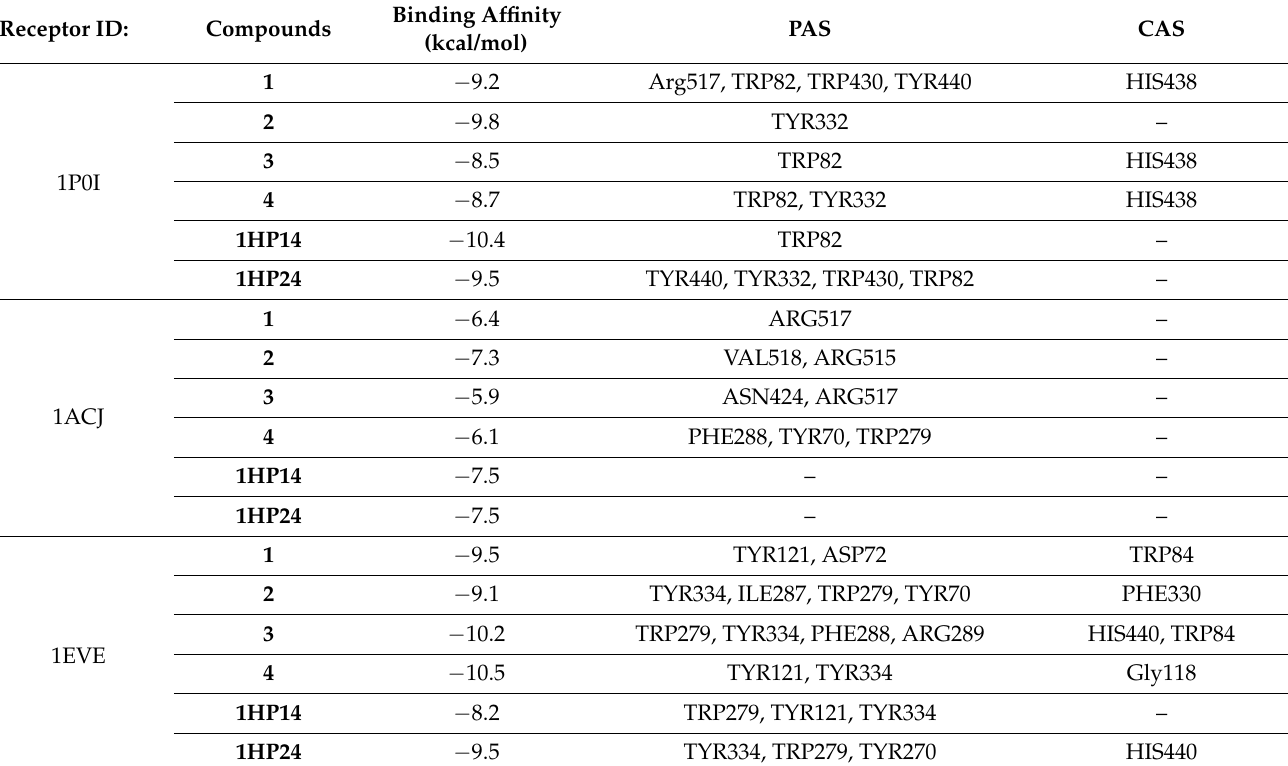
Table 5. Binding affinity values between selected ligands 1H1-4, 1HP14 and 1HP24 with different